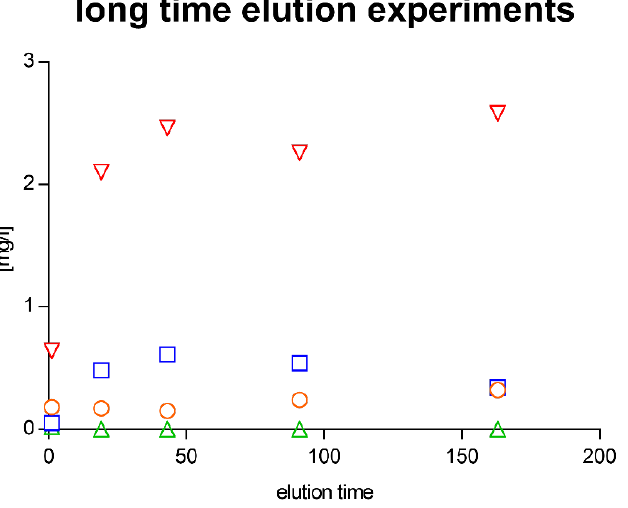
Figure 4. Long-term elution investigations on Cu-doped TEOS/MTEOS-sol – gel layers. Blue squares represent copper, red triangles sodium, orange circles calcium, and green triangles magnesium; elution time is given in hours (values represent 2 independent measurements).